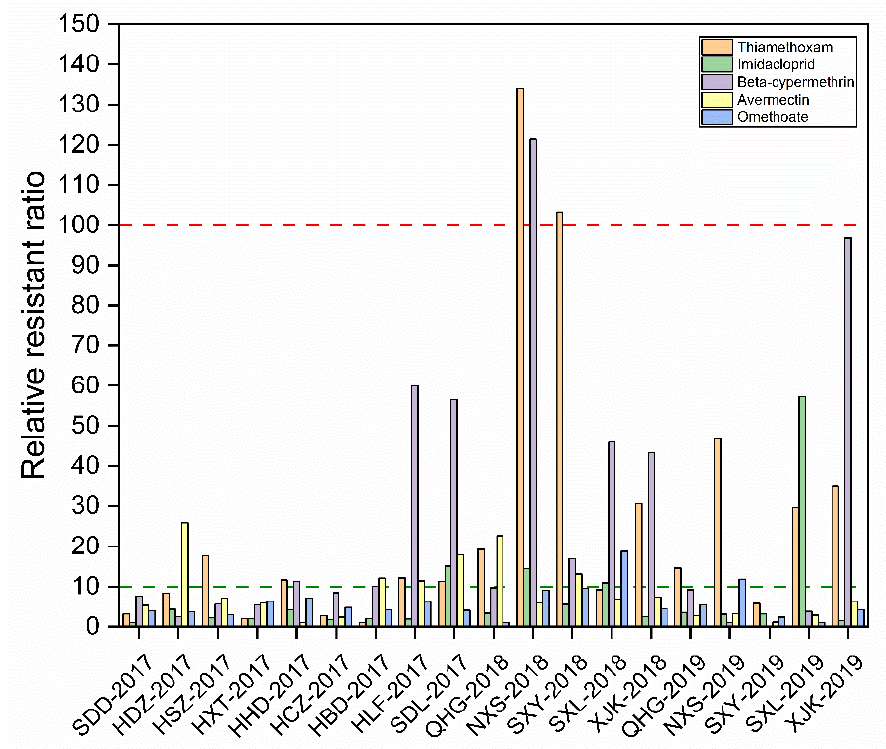
Figure 2. Relative resistance levels of Metopolophium dirhodum field populations.